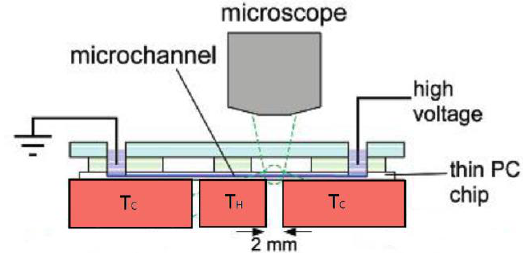
Figure 22. Schematic drawing of the Temperature Gradient Focusing apparatus. Reprinted with permission from [46]. Copyright 2002 American Chemical Society.